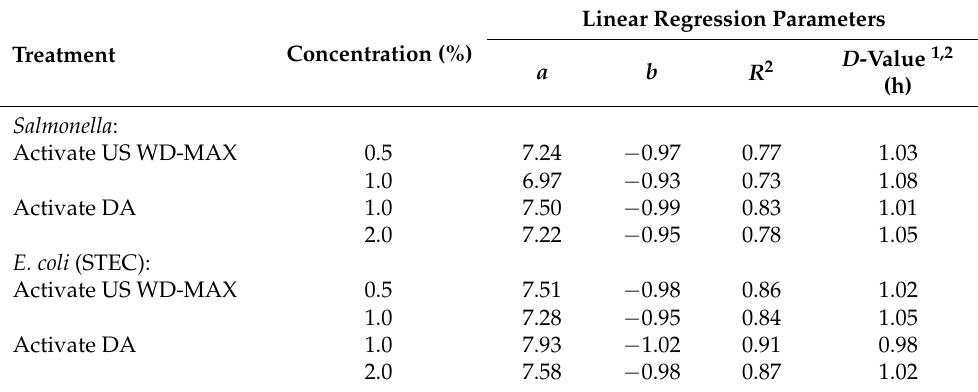
Table 6. Linear regression (linear model y = a + bx ) parameters of logarithmic reduction of Salmonella and E. coli (STEC) counts in pet food kibble treatments with inclusion of organic acid mixtures Activate DA at 1% and 2% and Activate US WD-MAX at 0.5% and 1% concentrations as coating.